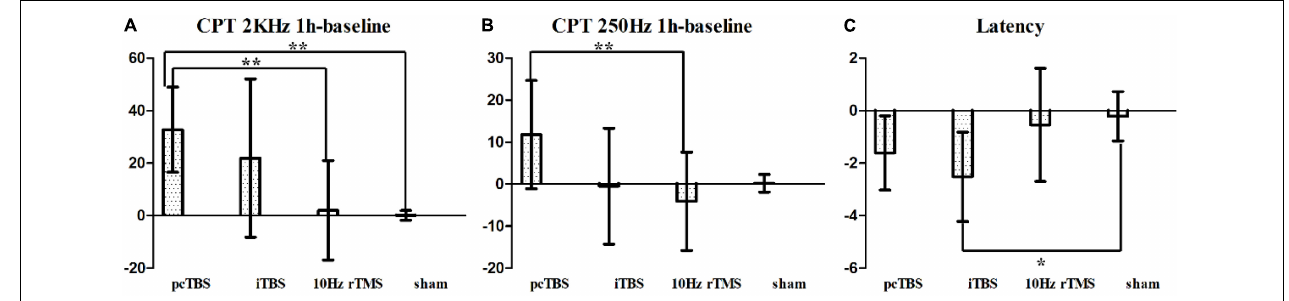
FIGURE 5 | (A) Changes in current perception threshold of 2,000 Hz between baseline and 1 h after stimulation. (B) Changes in current perception threshold of 250 Hz between baseline and 1 h after stimulation. (C) Changes of latency in MEP between baseline and 1 h after stimulation. pcTBS, prolonged continuous theta-burst stimulation; iTBS, intermittent theta-burst stimulation; rTMS, repetitive transcranial magnetic stimulation. * P < 0.05; ** P < 0.001 (not significant